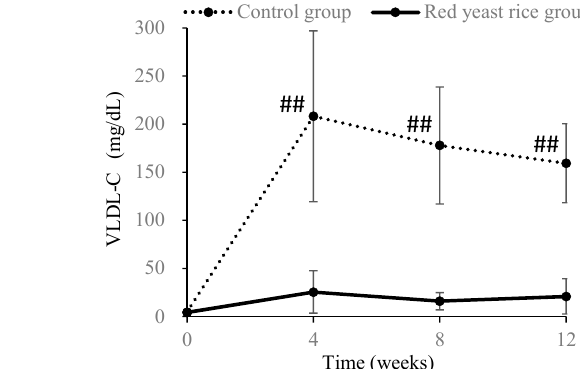
Figure 17. Time course change in contents of cholesterol in plasma low-density lipoproteins (chylomicron-cholesterol and VLDL-cholesterol) obtained from a red yeast rice-treated and control groups of hypercholesteremic model rabbits. Each bar indicates the mean ± standard deviation. Significant differences between control group and red yeast group were tested by Student's t-test (##: p < 0.01). Plasma lipoprotein cholesterol was quantified according to the reference method [51]. Red yeast rice has the potential to prevent vascular disease associated with hyper- lipidemia or reduce the risk for these diseases, through suppression of atheroma for- mation and improve blood fluidity, by lowering levels of chylomicrons and VLDL, lipo- proteins that are the main components of plasma chyle. 3.3. Promising Effects of Ingredients in Red Yeast Rice on Risk Reduction for Circulatory Diseases The evidence presented above suggests red yeast rice could reduce the risk of vascu- lar diseases associated with hyperlipidemia; however, red yeast rice also contain statins and various other ingredients which are effective in the circulatory system. Table 4 sum- marizes the potential effects of monacolin K (lovastatin) on circulatory diseases, including cardiac disease. There has been a lot of evidence reported on the favorable actions of